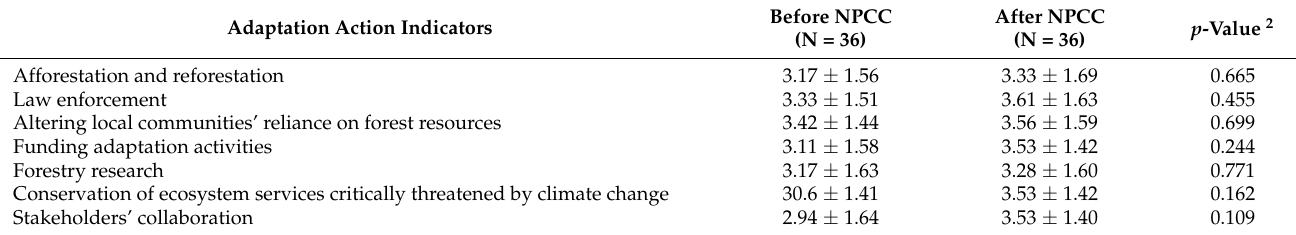
Table 2. Indicators of actions scores of the implemented policy before and after NPCC 1